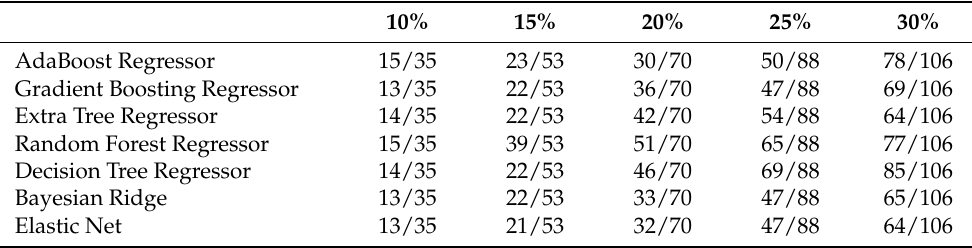
Figure 4. Evaluation Measures for each algorithm for DBpedia v3.8. Table 6. TP for test results of DBpedia v3.8 (Predicted Nodes/Actual